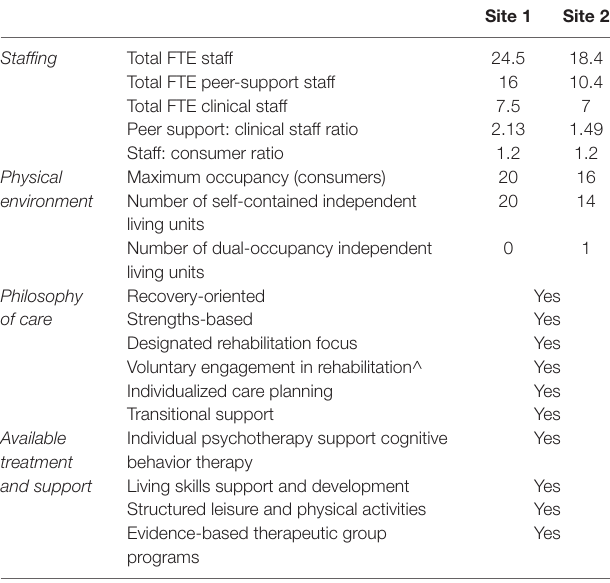
TABLE 2 | Characteristics of study